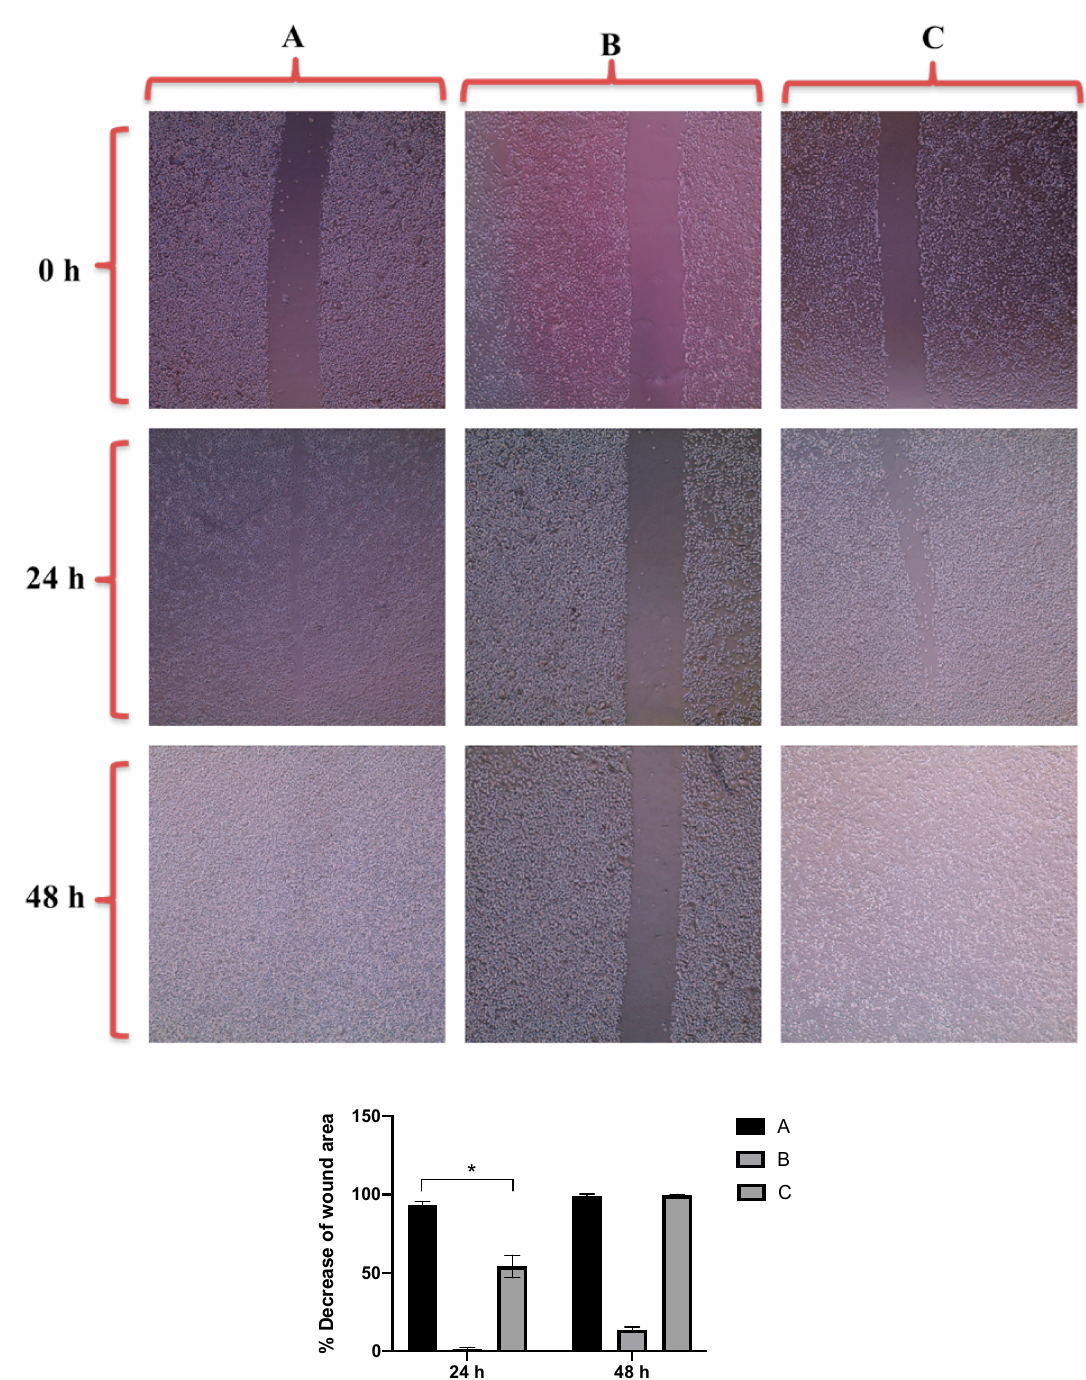
Figure 7. Up: In vitro cell migration of PC3 cell line (control untreated cells) ( A ), upon treatment with positive control (quercetin) ( B ), and upon treatment with GNRs-PDA ( C ). Magnification power: 10 × . Down: The percentage decrease in wound area was estimated using ImageJ. Data are represented as mean ± standard deviation (SD), n = 3. t -test was employed for the difference assessment; * p < 0.05.